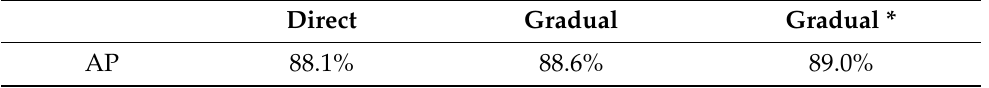
Table 2. Quantitative evaluation of the multiple receptive field feature integration.